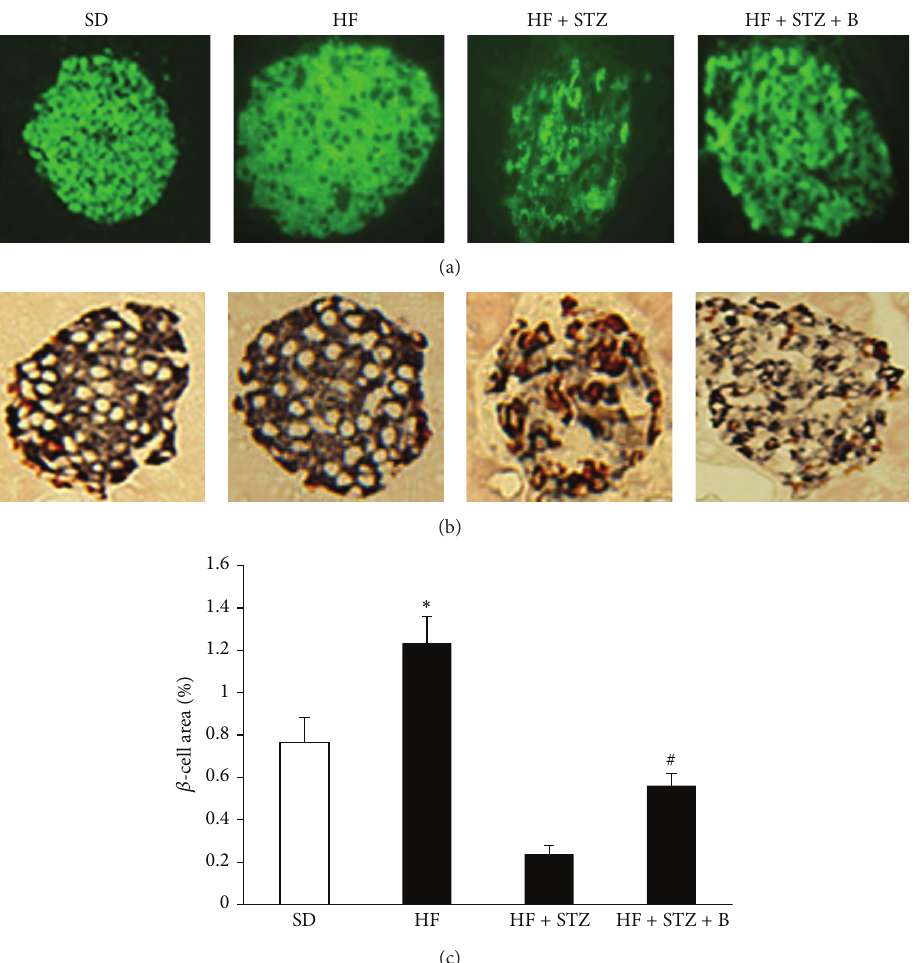
Figure 5: Baicalein supplementation improved pancreatic 𝛽 -cell mass and reduced apoptosis. Pancreatic sections from mice given SD, HF, HF, and STZ administration (HF + STZ) and HF + STZ supplemented with baicalein (B, 0.5 g/kg diet) were fluorescently stained with insulin (a) or double stained with activated caspase-3 (red) and insulin (blue) (b). The 𝛽 -cell mass was determined as described in the Methods section (c). Data are shown as means ± SE ( 𝑛 = 6 – 10 mice/group). ∗ 𝑃 < 0.05 versus SD group, # 𝑃 < 0.05 versus HF + STZ